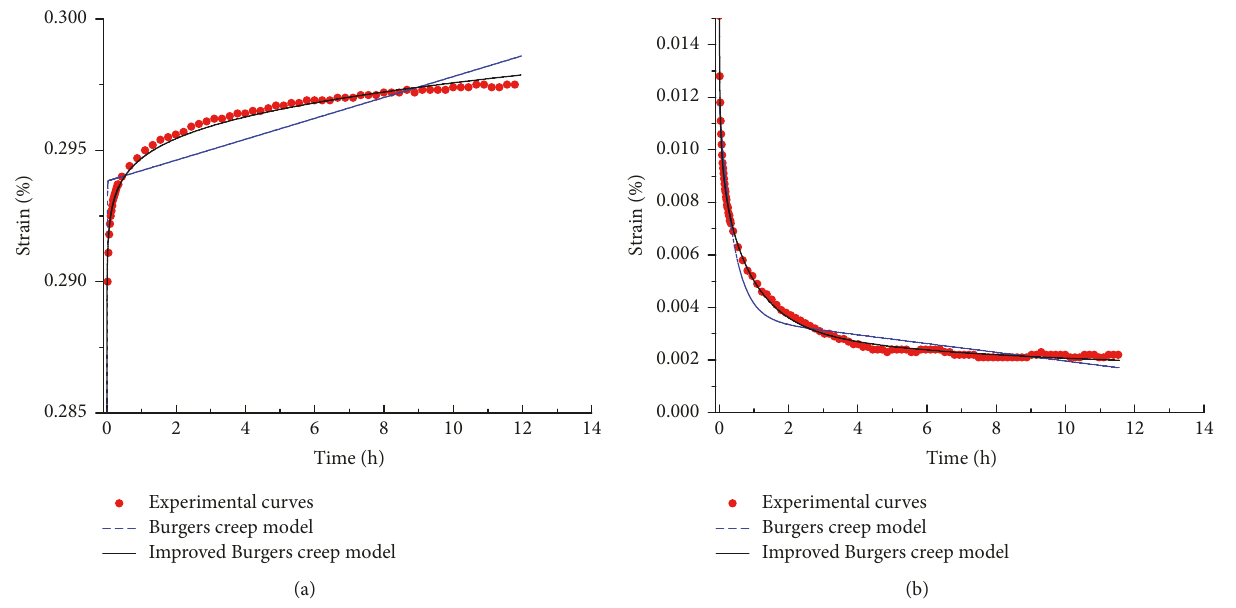
Figure 15: Comparison between calculated results and experimental results (a) under compressive stress of 10.86 MPa and (b) under tensile stress of − 0.28